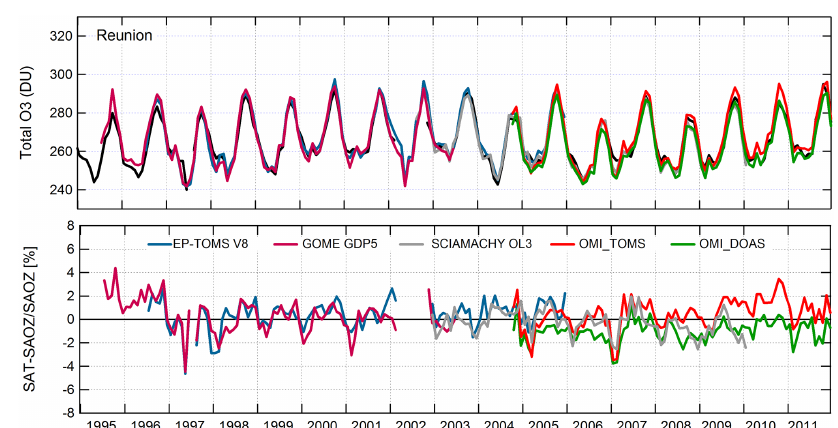
Figure 5. Same as Fig. 3 but for Reunion.